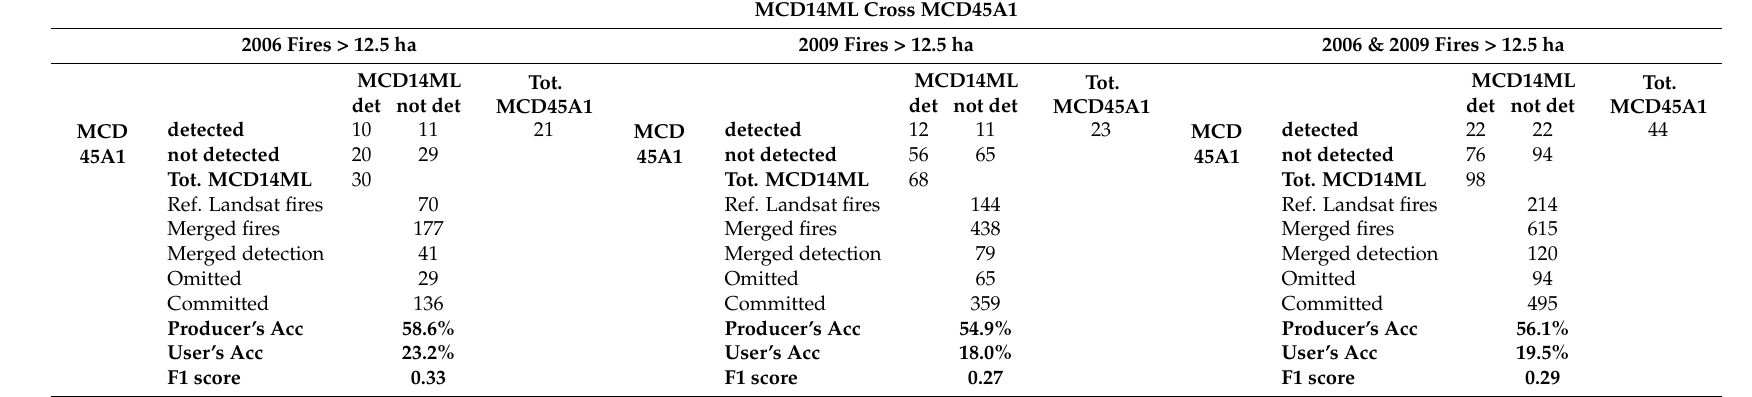
Table 5. Cross-comparison of reference fires detected and not detected by MODIS MCD14ML (active fire) and MCD45A1 (burned area). The tables emphasize fires detected by both products, fires detected by only one of the two products, and fire not detected by both products. This cross-comparison is useful to evaluate if the two products are sensitive to the same fire events or detect different fire events. Producer’s accuracy is calculated using the detection rate of a possible merged product (merged